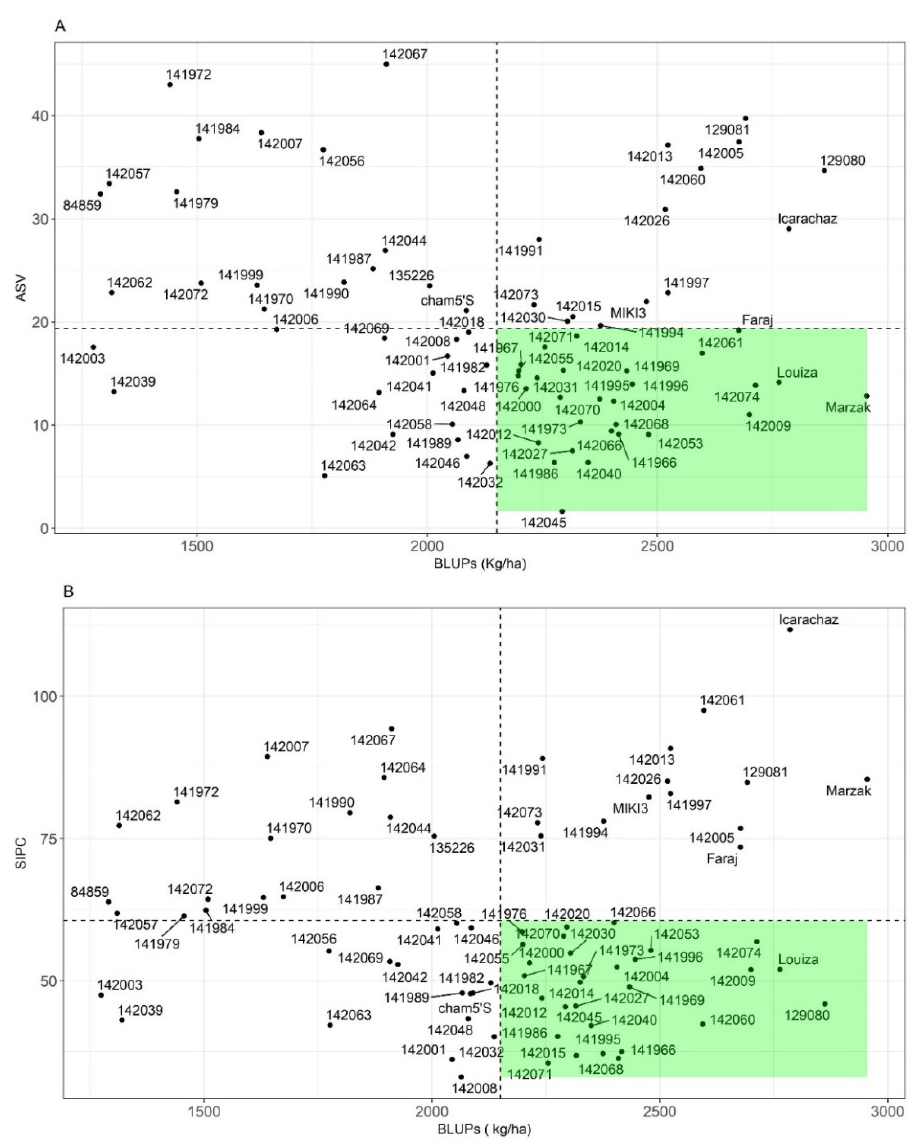
Figure 6. Plot of the best linear unbiased predictions (BLUPs) for grain yield versus the AMMI stability value (ASV) stability ( A ) and sum of the absolute value of the IPC scores (SIPC) ( B ) of tested durum genotypes. Vertical dashed line represents the average of BLUPs while the horizontal dashed lines represent the average of ASV ( A ) and SIPC ( B ). The green area represents the most desirable lines. Some labels were repelled using black arrows to avoid overlapping.